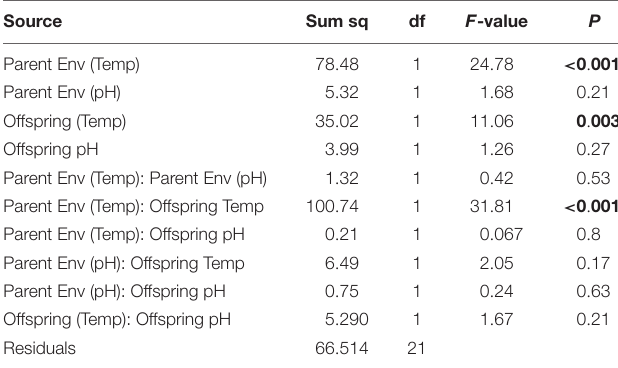
TABLE 4 | Generalized linear models (GLMM) analyses of covariance (ANCOVA, Type III) on the effect of parental acclimation environment (ambient, + 2 ◦ C, + 3 ◦ C;